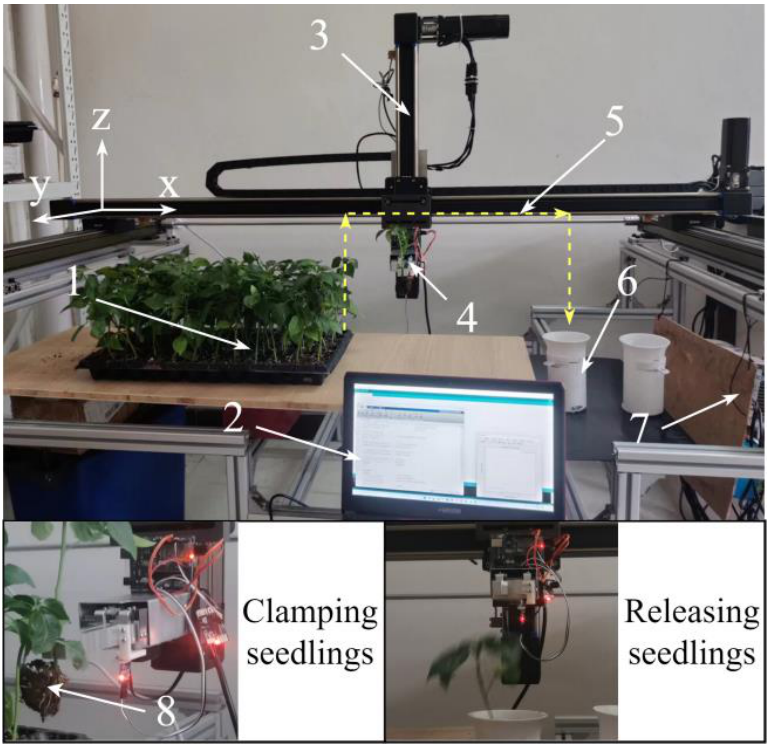
Figure 11. The force feedback gripper pick-up test: 1. Source tray 2. Computer 3. Linear manipulator 4. Gripper 5. Transplanting trajectory 6. Destination pot 7. Control unit 8. Potted seeding.